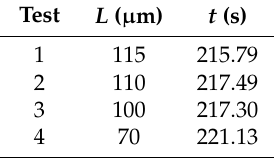
Figure 9. Validation of calculated molten pool dimensions to the documented experimental values based on the solidification microstructure. P = 180 W, V = 600, 800, 1000 and 1600 mm/s, respectively. Table 4. Predicted molten pool length and computational time under test 1–4 process conditions.